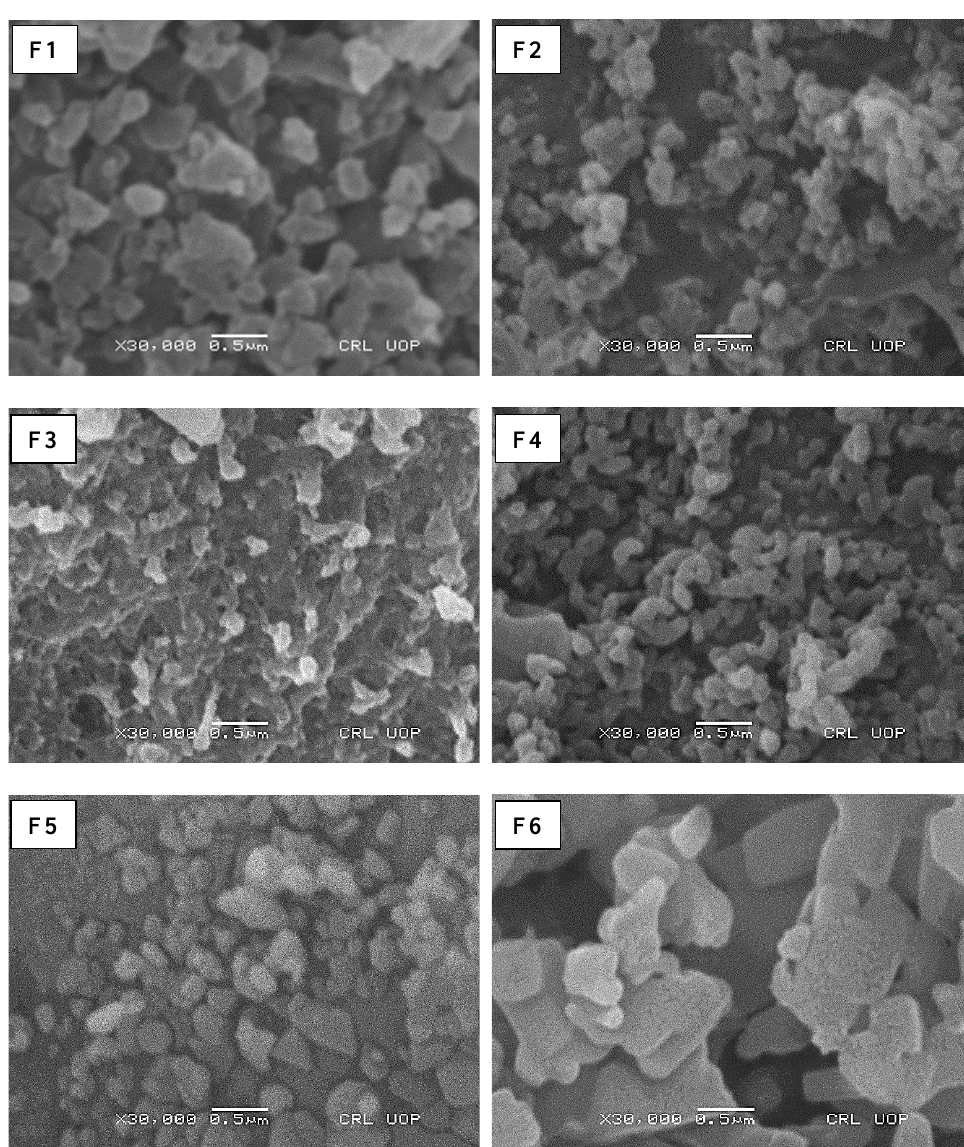
Figure 1. S.E.M. analysis of prepared nanoparticulate formulations.